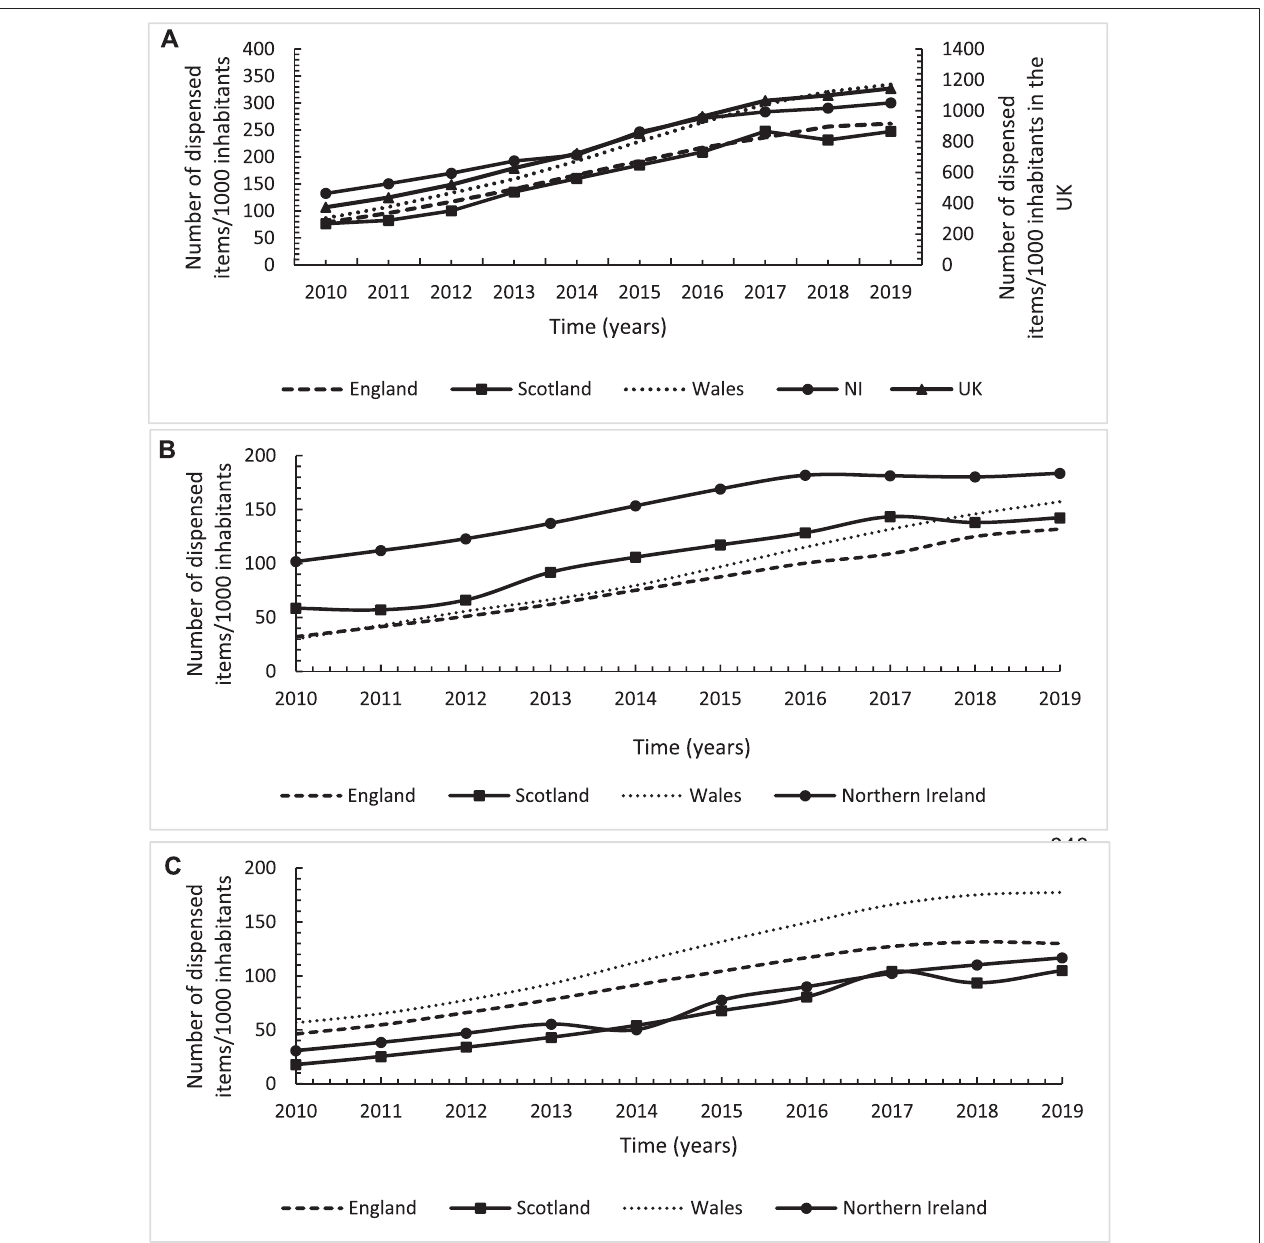
FIGURE 3 | Annual utilisation trends in number of dispensed items/1,000 inhabitants for gabapentinoids across England, Scotland, Wales and Northern Ireland over the study period from 2010 to 2019; (A) : Total gabapentinoids; (B) : Pregabalin; (C) : Gabapentin.